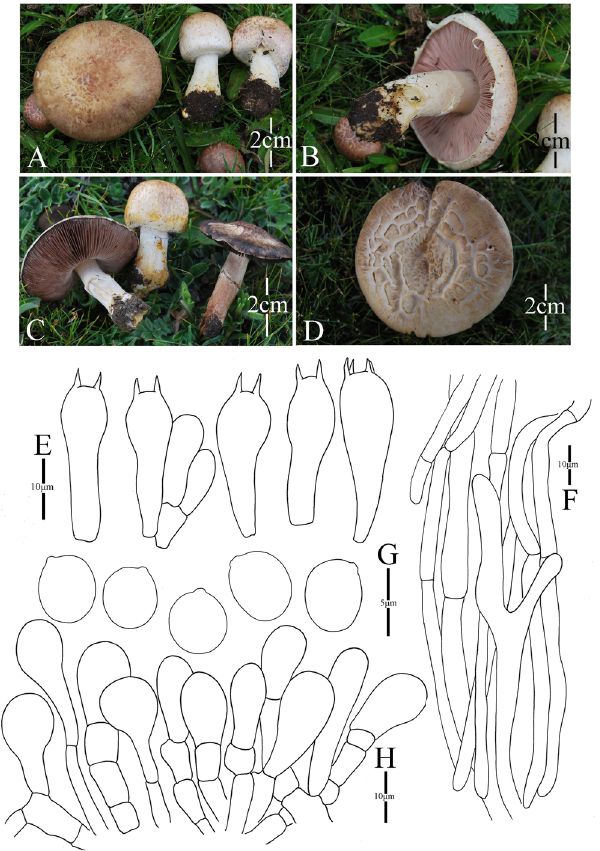
Figure 12. Morphology of Agaricus globosporus ( ZRL2012656 , holotype), ( A – D ): Basidiome in field ( A , B ): ZRL2012656 , ( C ): ZRL2012652 , ( D ): ZRL2012655 ), ( E ): Basidia, ( F ): Pileipellis hyphae, ( G ): Basidiospores, and ( H ):